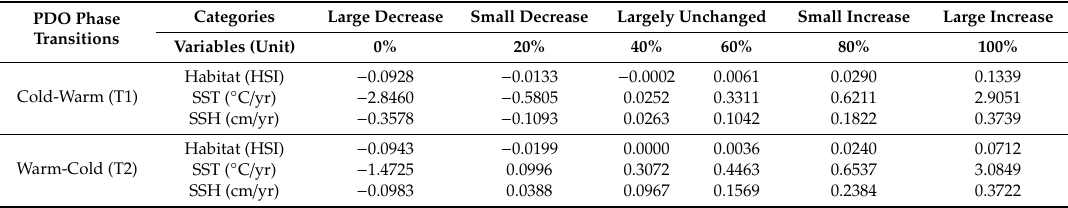
Table 3. Computed quintiles for the temporal trends of potential habitat (HSI), thermal environment (SST) and mesoscale eddy field (SSH) for each PDO phase transition. The corresponding values were used to classify the variable-specific changes in the temporal